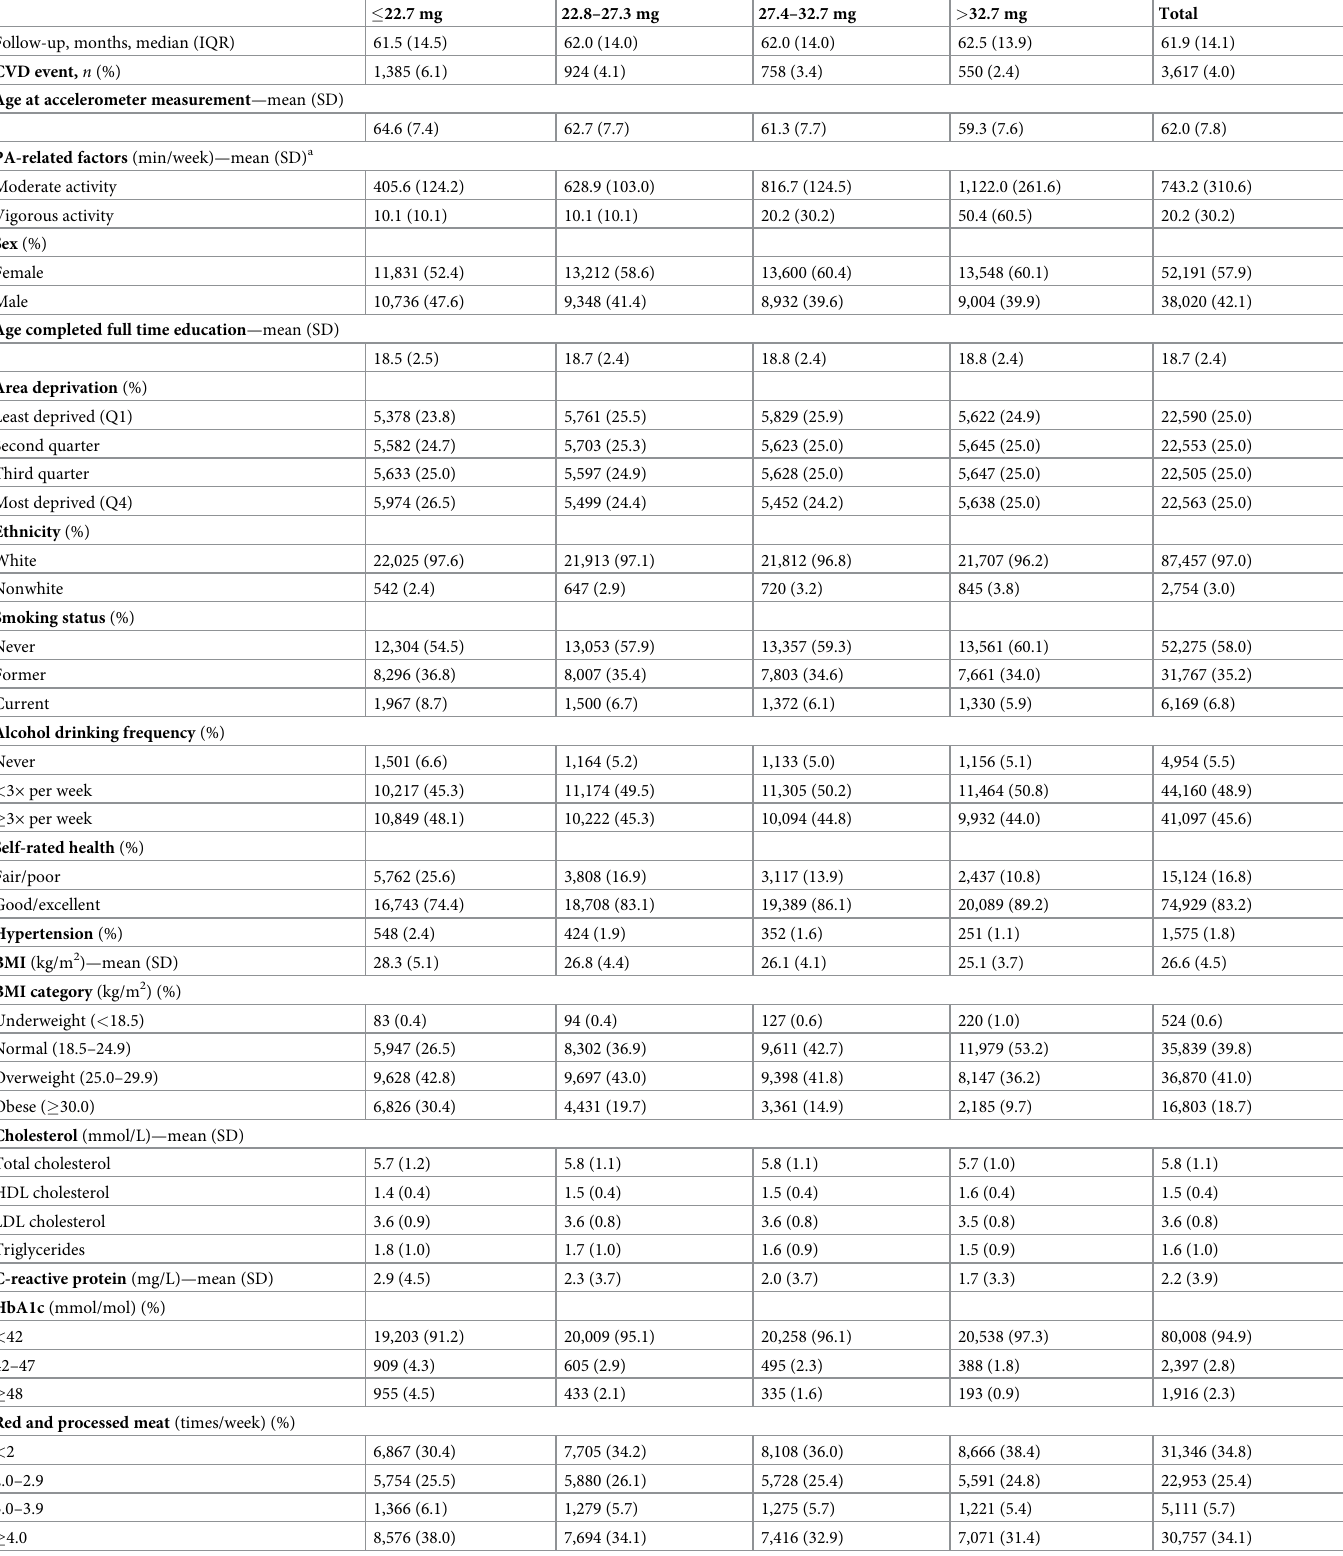
Table 1. Baseline characteristics of the participants in 2006–2010 by quarters of accelerometer-measured total volume of PA ( N =